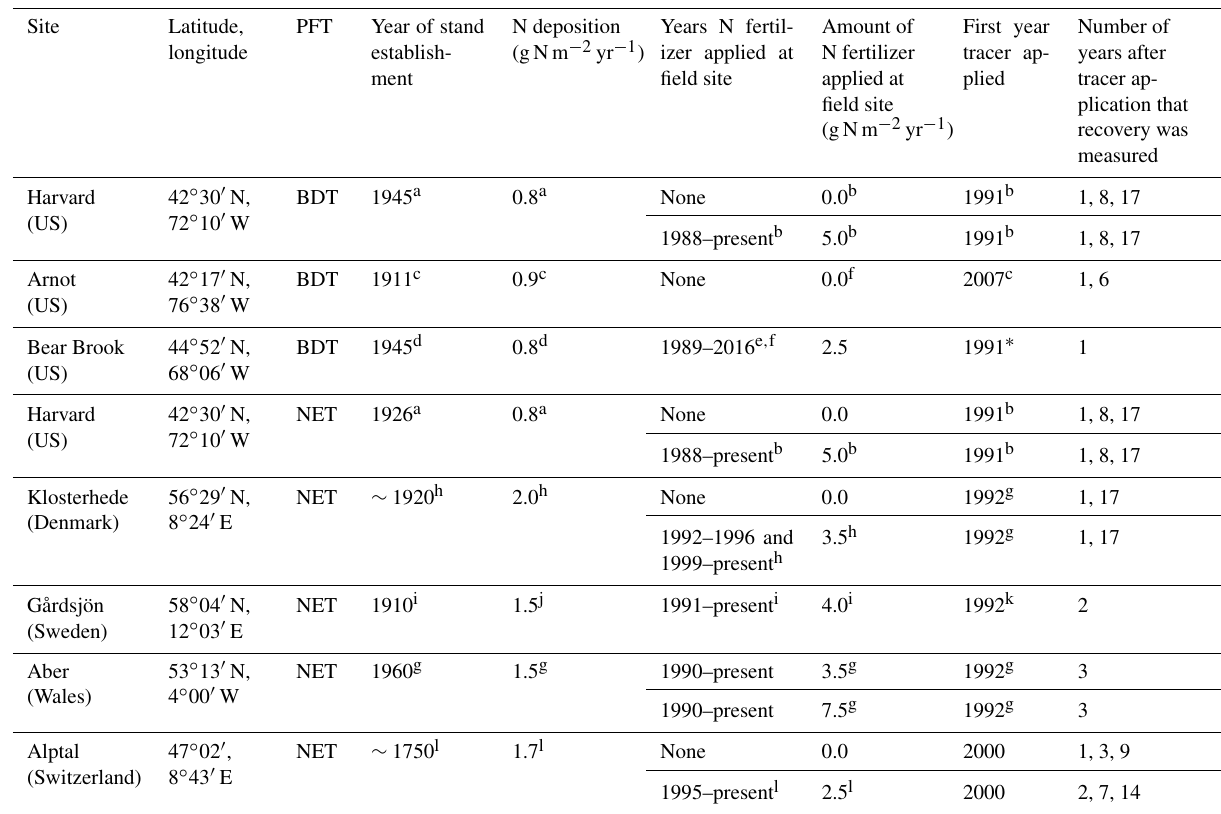
Table 1. Site information for long-term 15 N experiments in Europe and North America, including corresponding plant functional type (PFT) in CLM5, which is either broadleaf deciduous temperate (BDT) or needleleaf evergreen temperate (NET) tree. The year of stand establishment is the year in which we implemented a harvest in the model to simulate the forest’s reported stand age. N deposition is reported as throughfall or the sum of wet and dry N deposition as compiled from available literature. Tracer experiments at plots receiving ambient N deposition and fertilizer treatments are described on separate lines for each site. Please refer to Sect. 2.4 for details on how these field experiments were simulated using